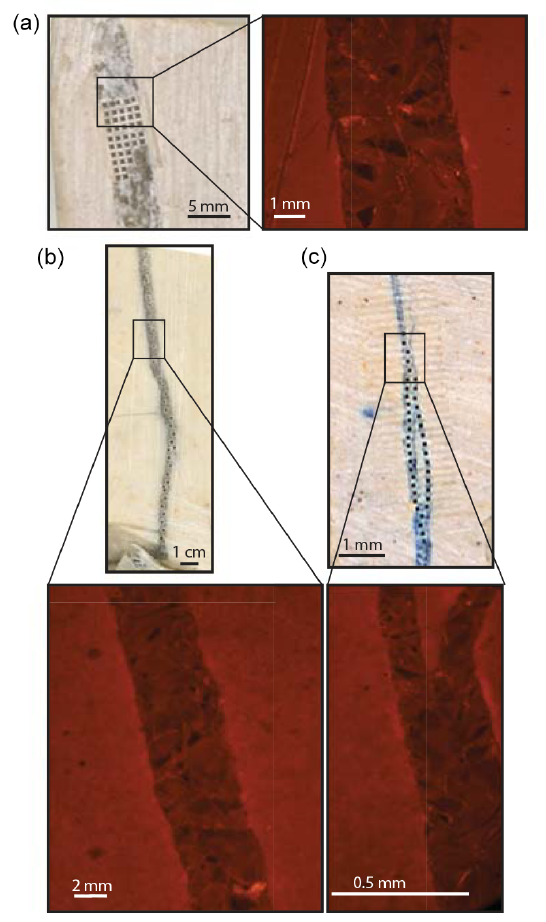
Figure 4. Two-dimensional scans of veins dated by LA-ICP-MS U–Pb geochronology from the San Vicino anticline, with the lo- cation of the ablation spots and diagenetic state observed under cathodoluminescence microscopy. (a) Sample A16 (LPS-related vein). (b) Sample A19 (syn-folding vein). (c) Sample A20 (LSFT- related